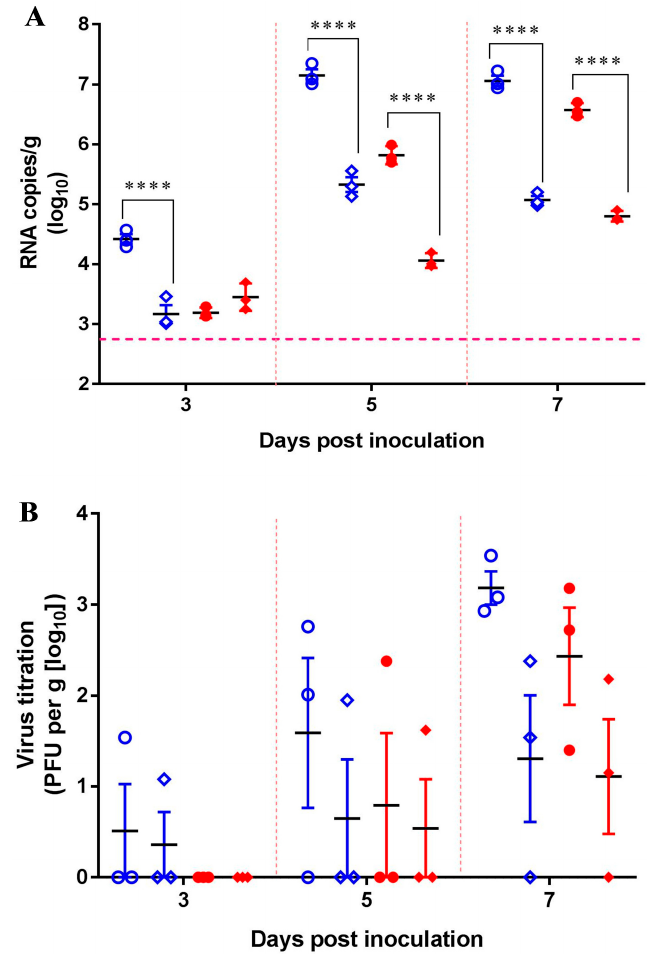
Figure 5 . Aerosol transmission of JEV in mice. The mice were infected i.n. with 10 6.0 pfu/50μl of the SCYA201201 or SA14-14-2 virus, respectively, and were housed in a cage with a double-walled wire partition that permitted airflow but prevented direct contact. The sentinel animals were added at 24 h post-infection. The mice were sacrificed, and their lungs were harvested at 3, 5, and 7 dpi. The SCYA201201 was marked with hollow symbols (infected with ○ and sentinel with ◇ ) and the SA14-14-2 was marked with solid symbols (infected with ● and sentinel with ◆ ). ( A ) The viral RNA load in the lungs was measured using real-time RT-PCR assay. The horizontal dotted lines indicate the limit of detection (**** P ˂ 0.0001). ( B ) The virus titer in the lung samples were determined by the plaque